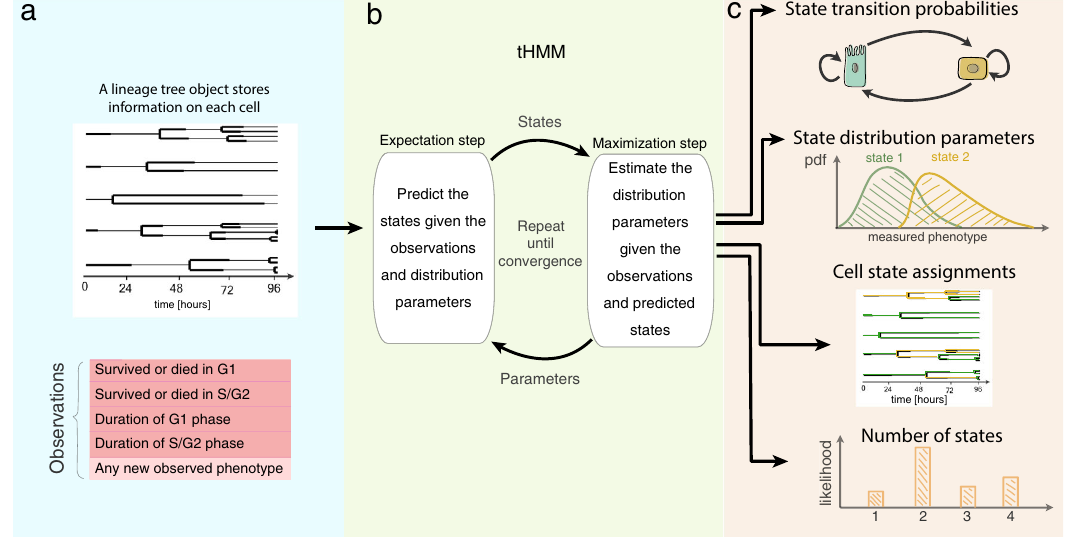
Fig. 2 The tHMM model. a Input data takes the form of single-cell measurements across time, where the lineage relationship between cells is known. b The fi tting process includes expectation and maximization steps, where model parameters are iteratively updated until convergence. c Output predictions of the model after fi tting including the tree of inferred cell states, probabilities of transition between each state, starting abundance of each cell state, and distributions that describe the behavior of cells within each state. The model likelihood can be used to estimate the number of distinguishable cell